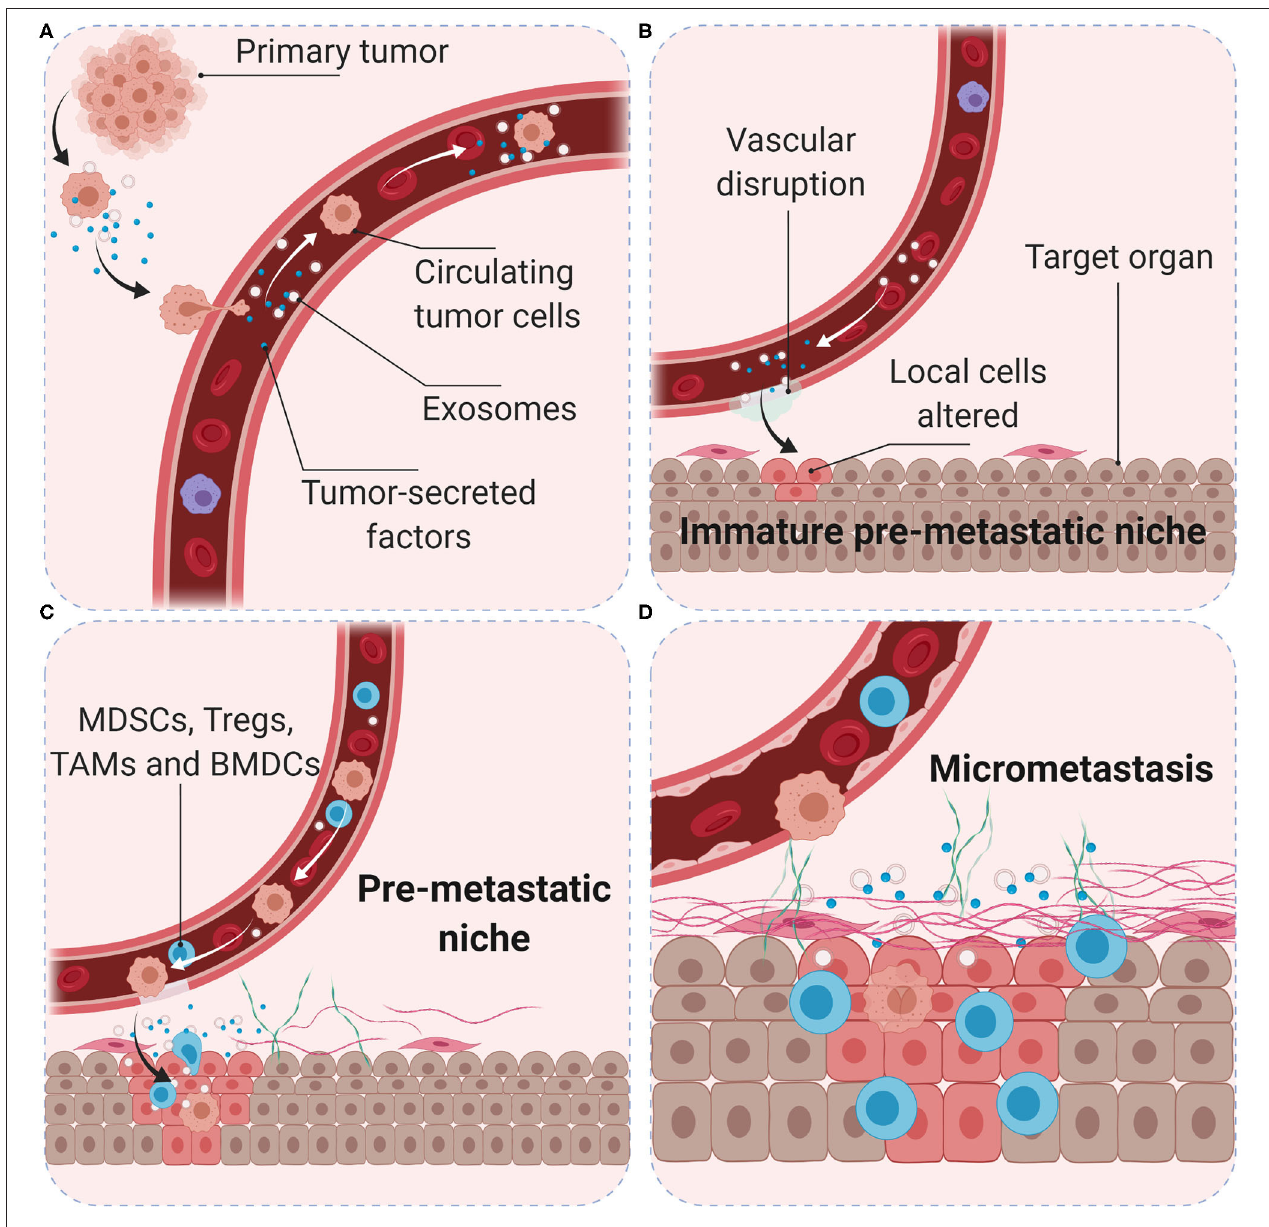
FIGURE 3 | Role of the pre-metastatic niche in cancer metastasis. Primary tumor cells produce soluble factors and exosomes (A) to trigger the formation of an immature pre-metastatic niche in the target organ (B) . Primary tumor conditions (hypoxia, acidity, and interstitial pressure) promote tumor cell migration into the blood vessels. Tumor-secreted factors and exosomes mobilize bone marrow-derived cells (such as CD11b + myeloid cells) and suppressive immune cells (such as MDSCs, T reg , and TAMs) to target organs (C) . Interactions with local stroma, hypoxia and active ECM remodeling may create a niche with suitable microenvironment conditions for tumor cell colonization (D) . Surgery, inflammation, and immunosuppression may increase the number and survival of circulating tumor cells and favor the development of